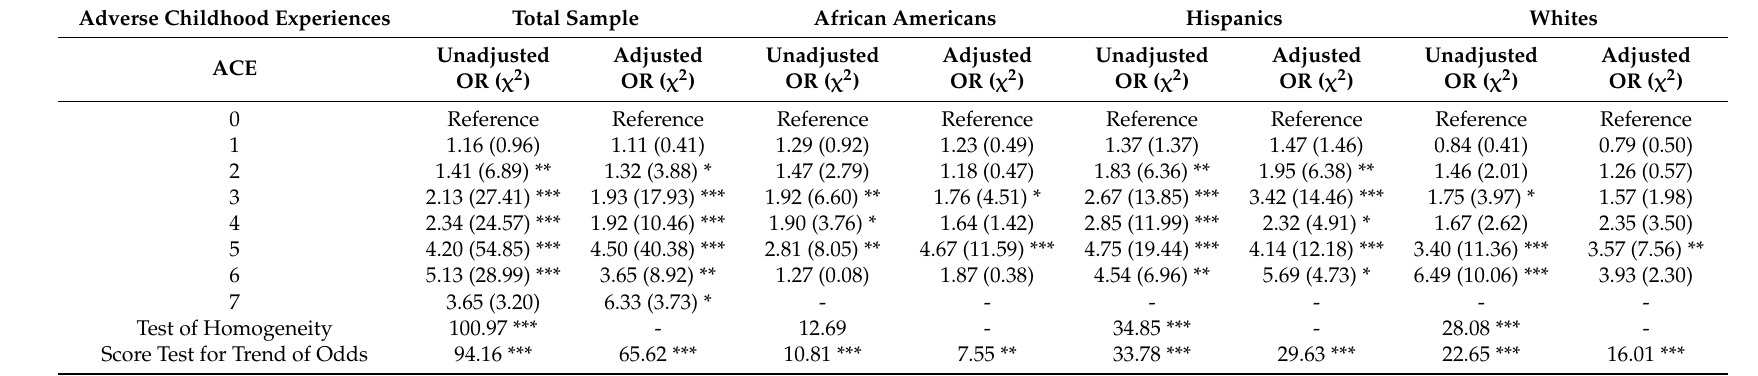
Table 2. Table of odds for sexual offense as commitment offense.